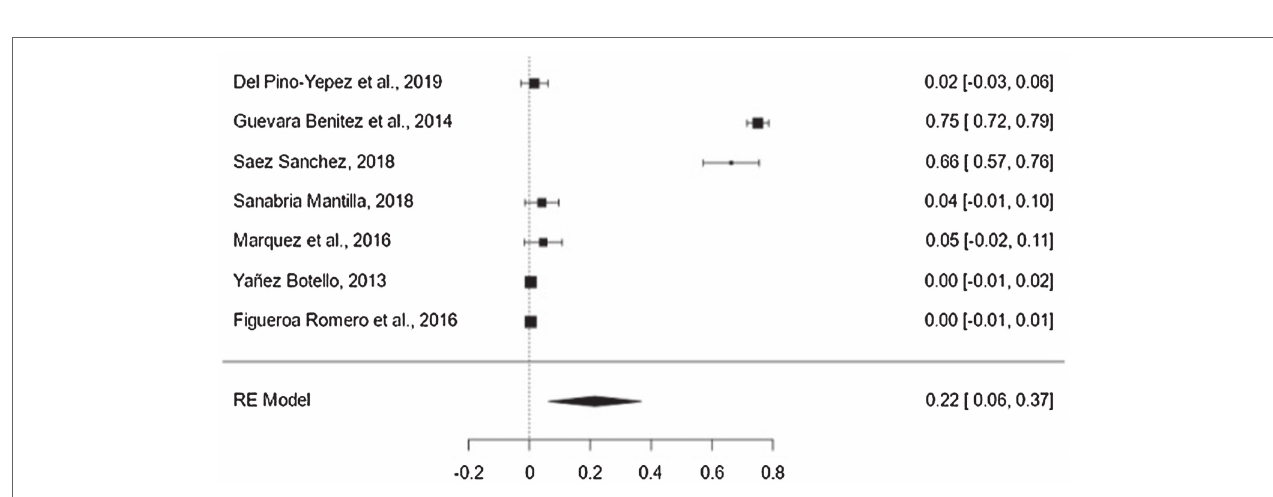
FIGURE 5 | Forest plot of organizational level.